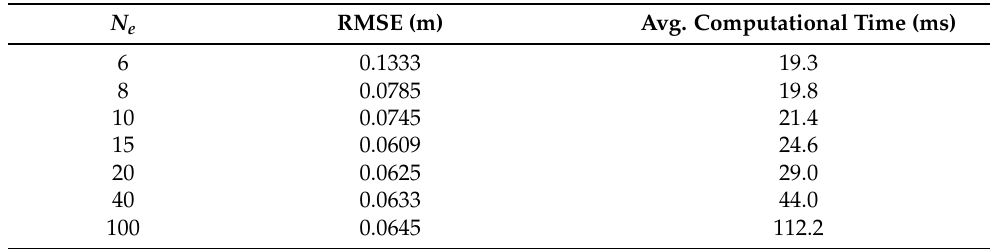
Table 1. Effect of increasing the estimation horizon N e on the performance and the average computa- tional time of the